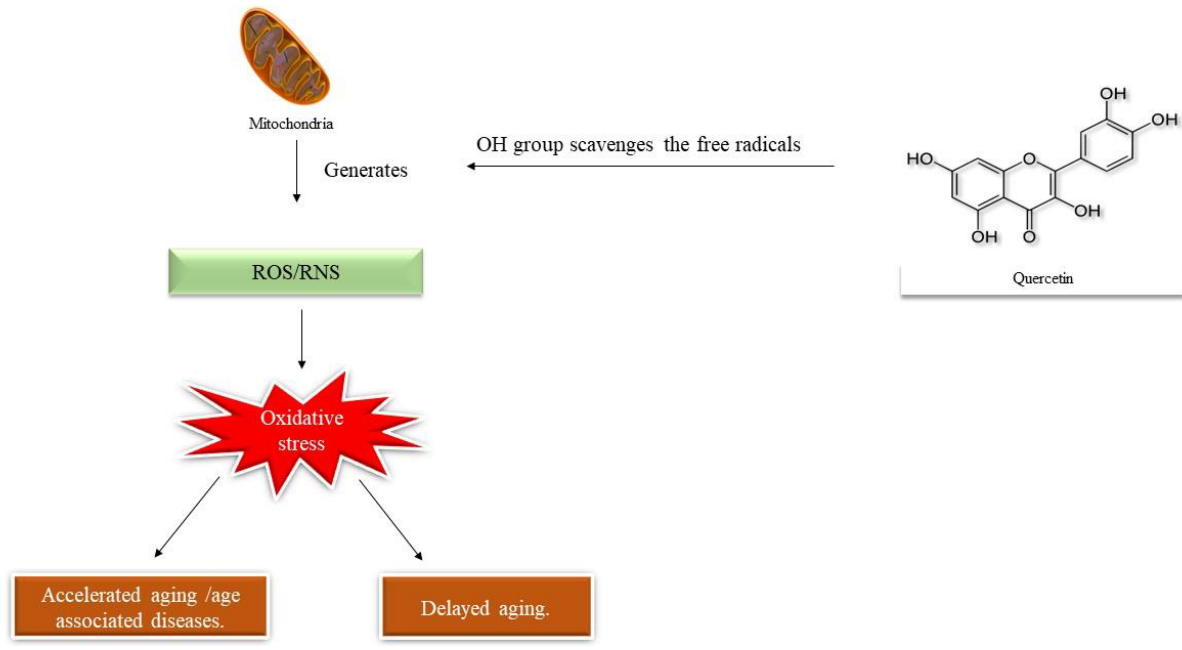
Figure 3. Mechanism of action of quercetin.